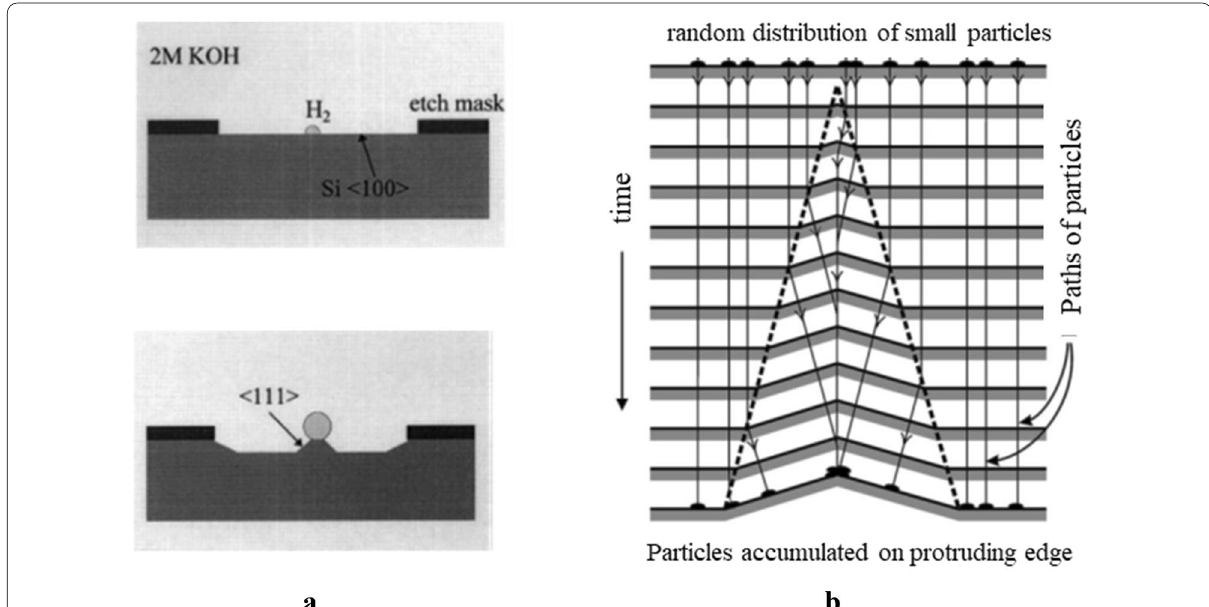
Fig. 9 Two models of micro-pyramid growth, both assuming etched products as micro-masking materials: a H 2 bubble sticks/grows on etched surface randomly [80], © 1997 IOP Publishing, and b Silicate particles accumulated on protruding edges according to a time sequence of etching [82], © 2001